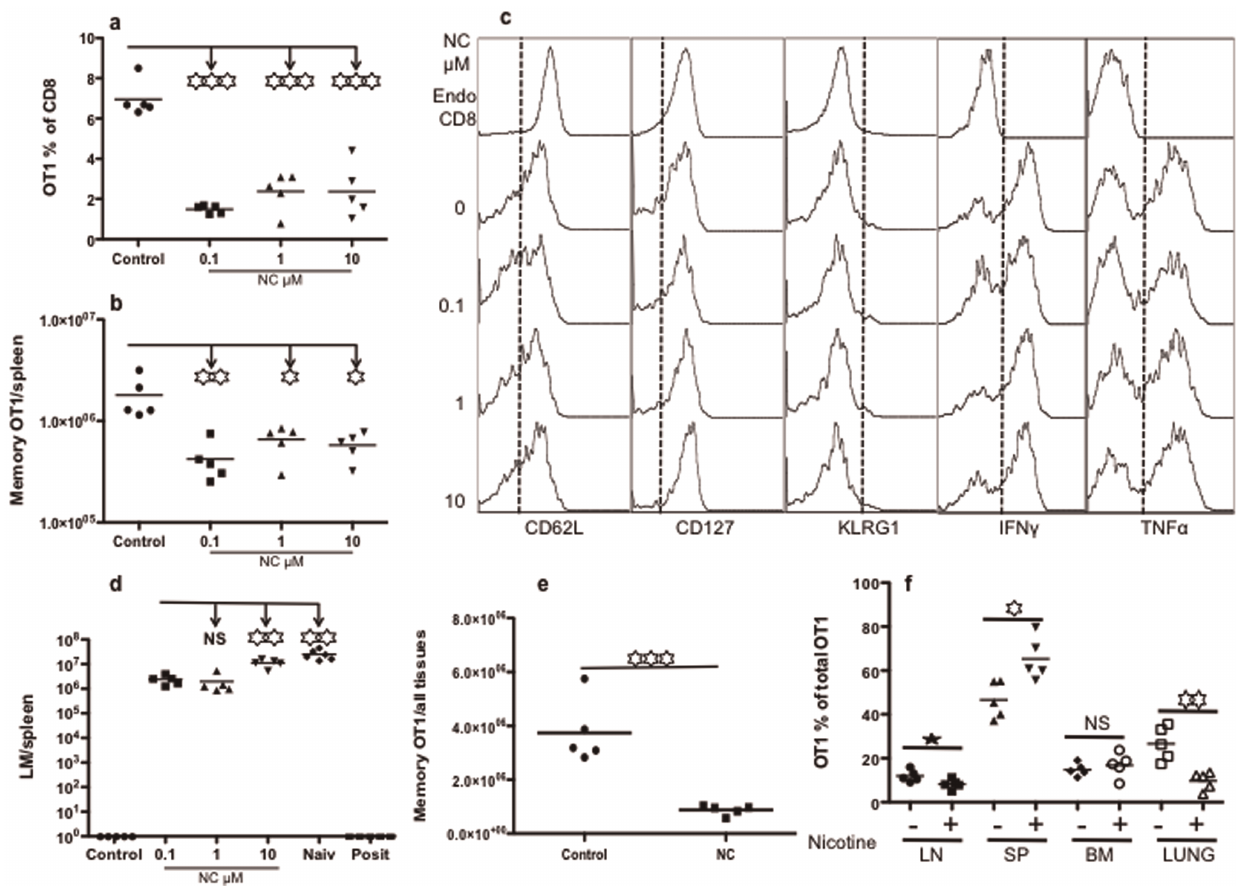
Figure 4. Nicotine impairs memory CTL programming. A–D: Purified OT-I cells were cultured for 3 days with 3SI in the presence of nicotine at different concentrations. Three days after stimulation, CTLs were harvested and transferred into B6 recipients at a concentration of 10 6